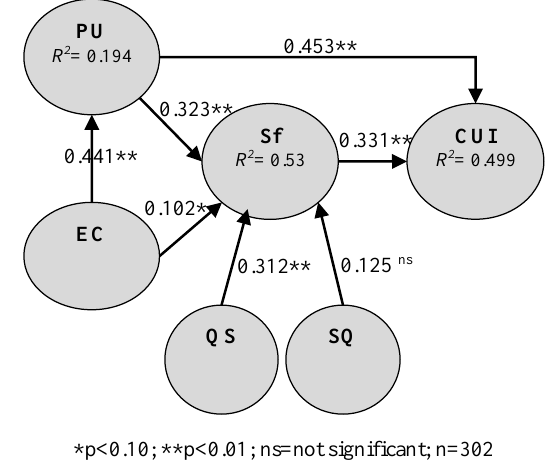
Figure 3. Structural model